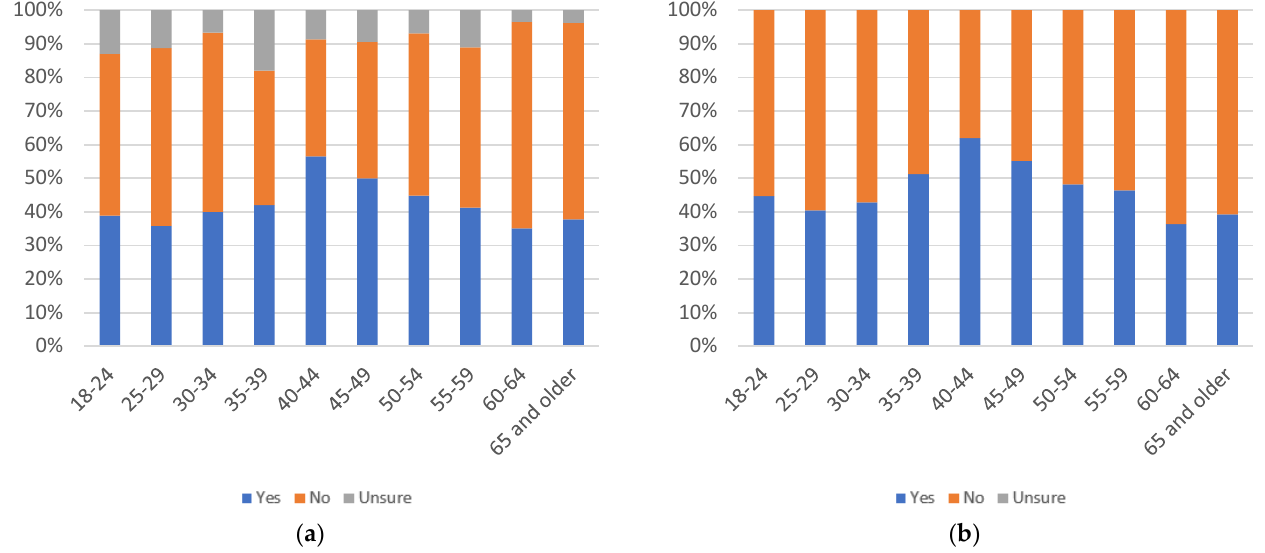
Figure 88. Label annoyingness, by age group: ( a ) with uncertain respondents (left) and ( b ) without uncertain respondents (right).